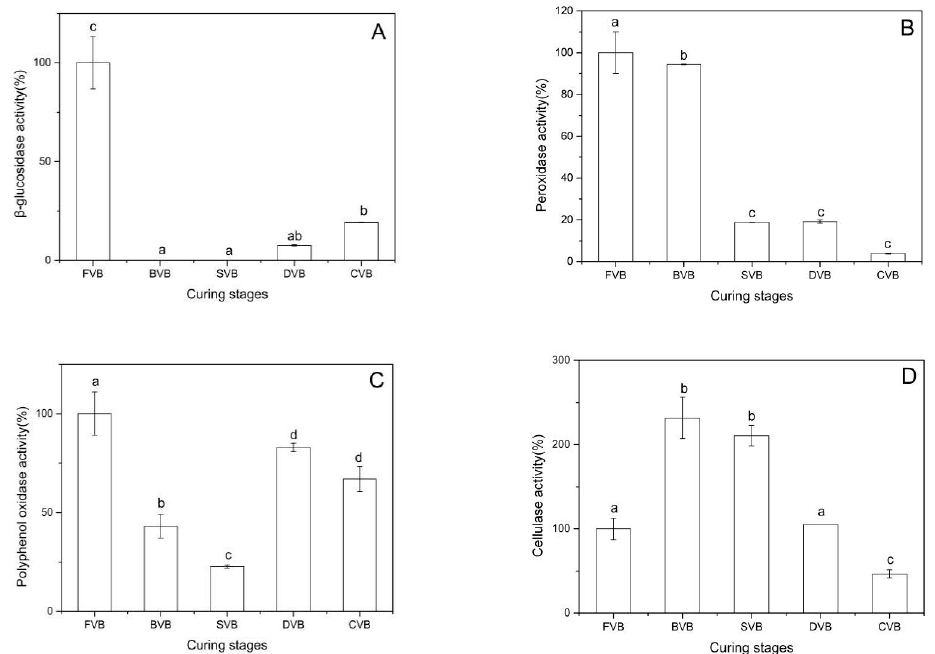
Figure 5. Enzymic activities in vanilla beans of the di ff erent curing stages: ( A ) β -glucosidase, ( B ) peroxidase, ( C ) polyphenol oxidase and ( D ) cellulase. Bars represent the standard deviation of the three replicates. Data were subjected to Duncan’s test ( p < 0.05). Di ff erent letters indicate quantities that are either statistically significantly di ff erent between di ff erent stages (a,b,c,d). FVB: Fresh vanilla bean; BVB: Blanched vanilla bean; SVB: Sweating vanilla bean; DVB: Drying vanilla bean; CVB: Cured vanilla bean.